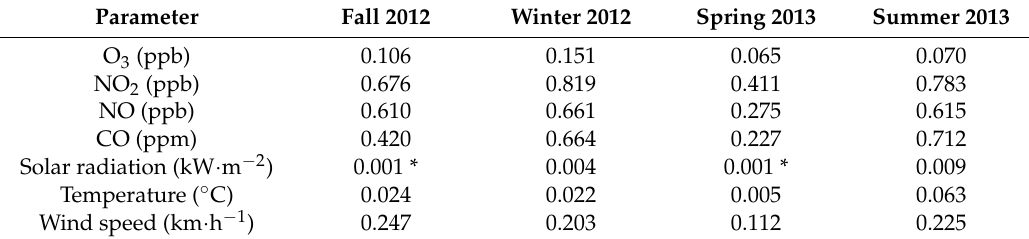
Table 4. Correlation coefficients ( R 2 ) between NO y and air pollutants and meteorological parameters recorded at the OBI site from September 2012 to August 2013.